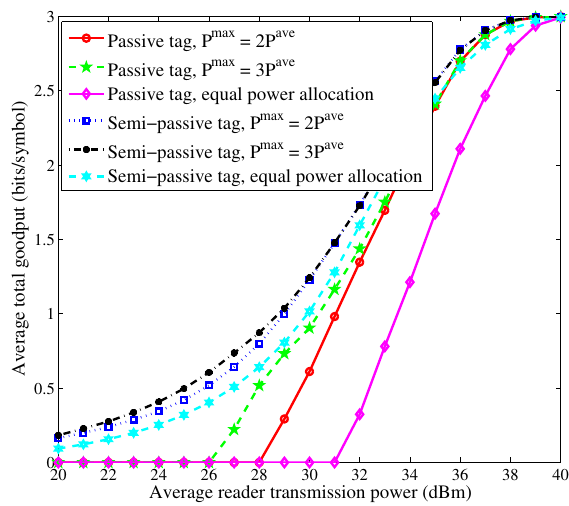
Figure 3. Average total goodput vs. average reader transmission power with N =